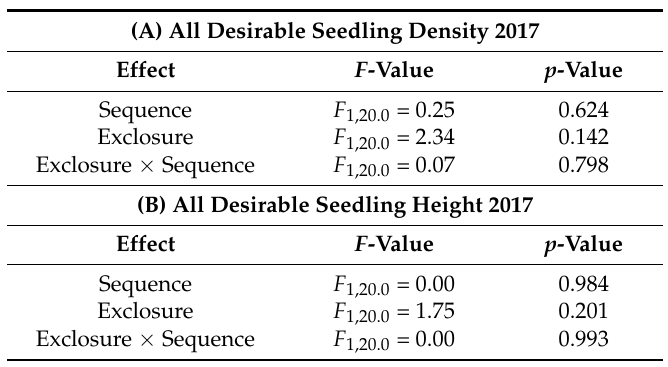
Table A2. Generalized linear mixed model results on ( A ) seedling densities and ( B ) seedling heights (cm) for all desirable species. Desirable species include Acer rubrum L., A. saccharum Marshall, Fraxinus americana L., Liriodendron tulipifera L., Magnolia acuminata L., Prunus serotina Ehrh., and Quercus rubra